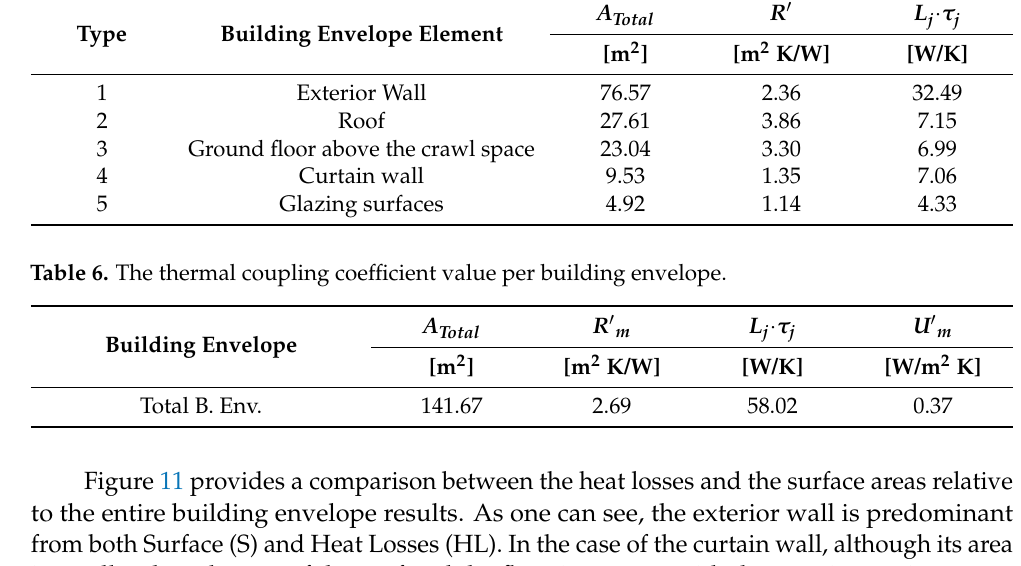
Table 5. The thermal coupling coefficient value ( 𝐿 ) per element 𝑗 .